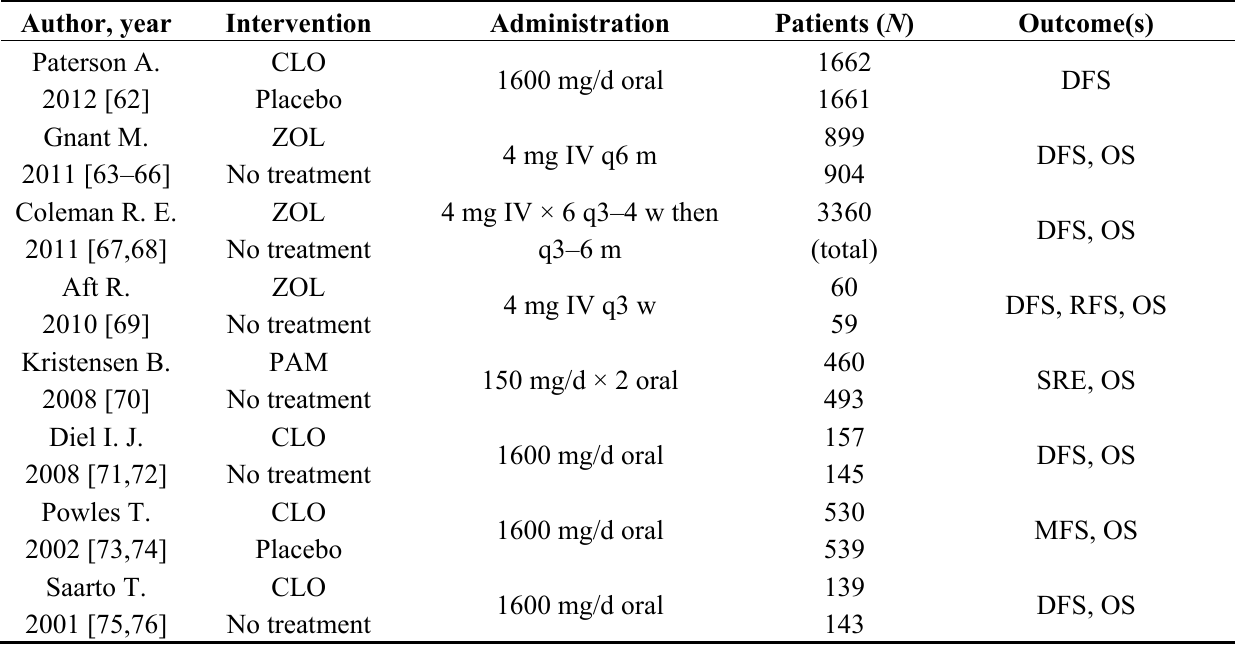
Table 3. Evidence on the use of BMAs as adjuvant therapy in patients with primary breast